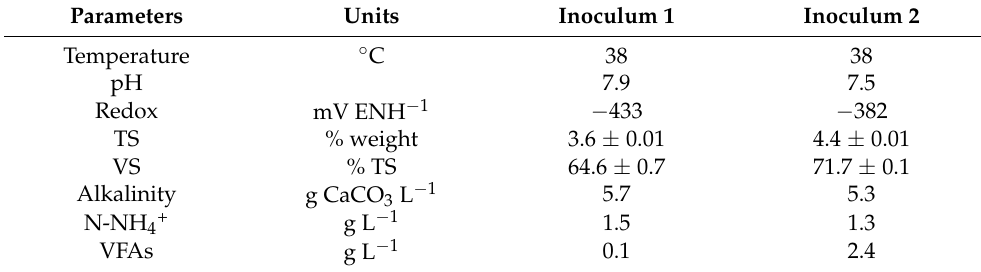
Table 1. Characterization of the two inoculum in terms of their main physico-chemical properties. Parameters